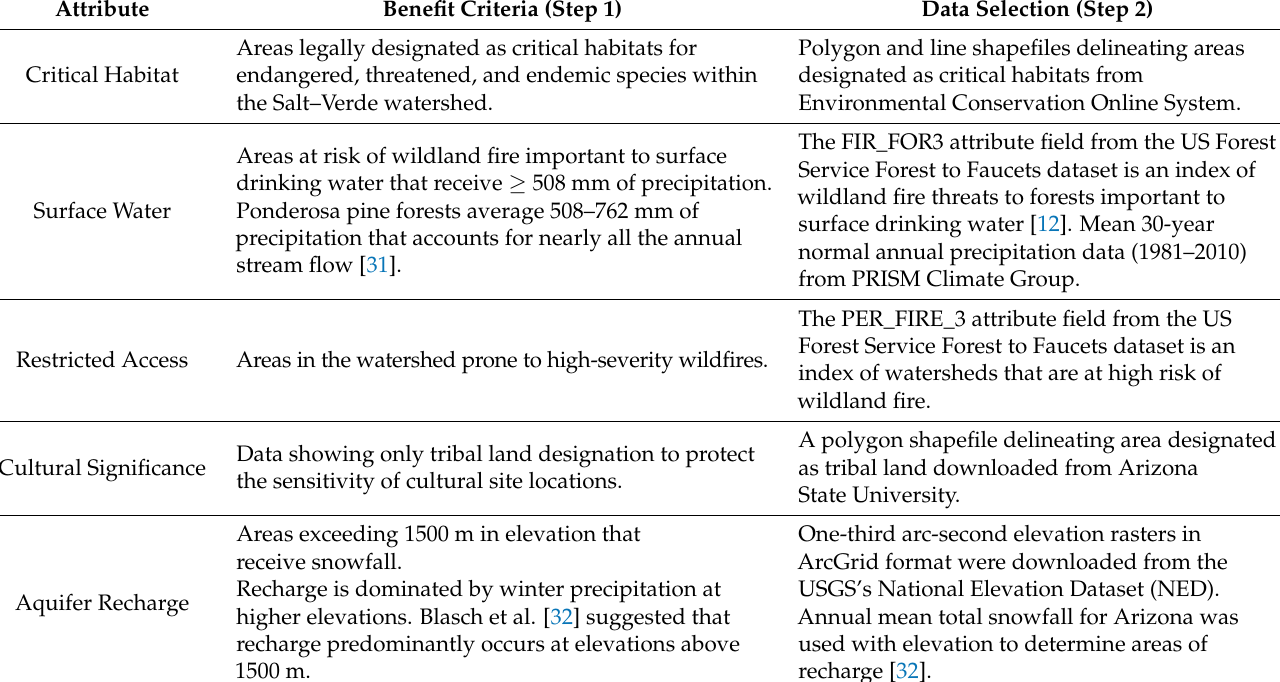
Table 2. Benefit criteria and data used in map layer